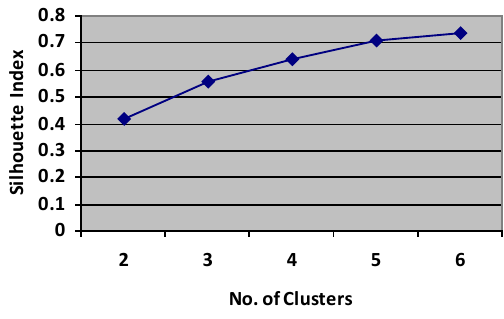
Fig. 8. Average Silhouette score for clustering 25 trajectories with different number of